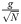
Random network with structured connectivity generates coherent chaos.(A) Network schematic showing neurons connected via random matrix J and rank-one structured connectivity. The structured component is represented schematically as a loop with drive through the output mode, ν, and feedback through the input mode, ξ. In our model these two vectors are orthogonal. The standard deviation of the random component is given by gN and the strength of the structured component is J1N. (B) Sample network dynamics without structured component, i.e. J1 = 0. Colored traces show a random collection of ten neural activity patterns, ϕj, black trace shows the coherent mode activity, ϕ¯=1NξTϕ, which exhibits only miniscule fluctuations. (C) Sample dynamics for J1 = 1. Coherent mode displays substantial fluctuations. (D) Coherence, χ (definition in text), as a function of the strength of structured connectivity component, J1 for small values of J1. Simulation and theory (valid in the weak structured connectivity regime—J1 ≪ g) shown for both g = 1.5 and g = 2. Bars show standard deviation over 60 realization of the random connectivity. (E) Passive coherent chaos. With weak structured connectivity fluctuations of the coherent mode follow the fluctuations of the independent residual components. Normalized autocorrelation of the coherent component of the current, q¯(τ), in red circles. Average normalized autocorrelation of the residuals, qδ(τ), in blue ‘x’s. Both are averaged over 60 realizations of the random connectivity with J1 = 0.1. Prediction from theory in black. N = 4000 and g = 2 in all panels unless stated otherwise.